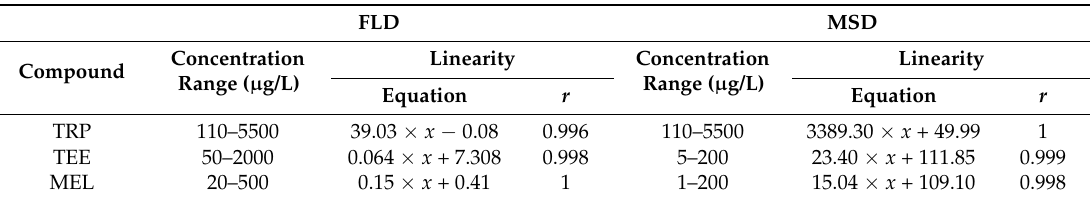
Table 1. Linearity obtained with standard synthetic wine solutions by fluorescence (FLD) and mass spectrometry (MSD)